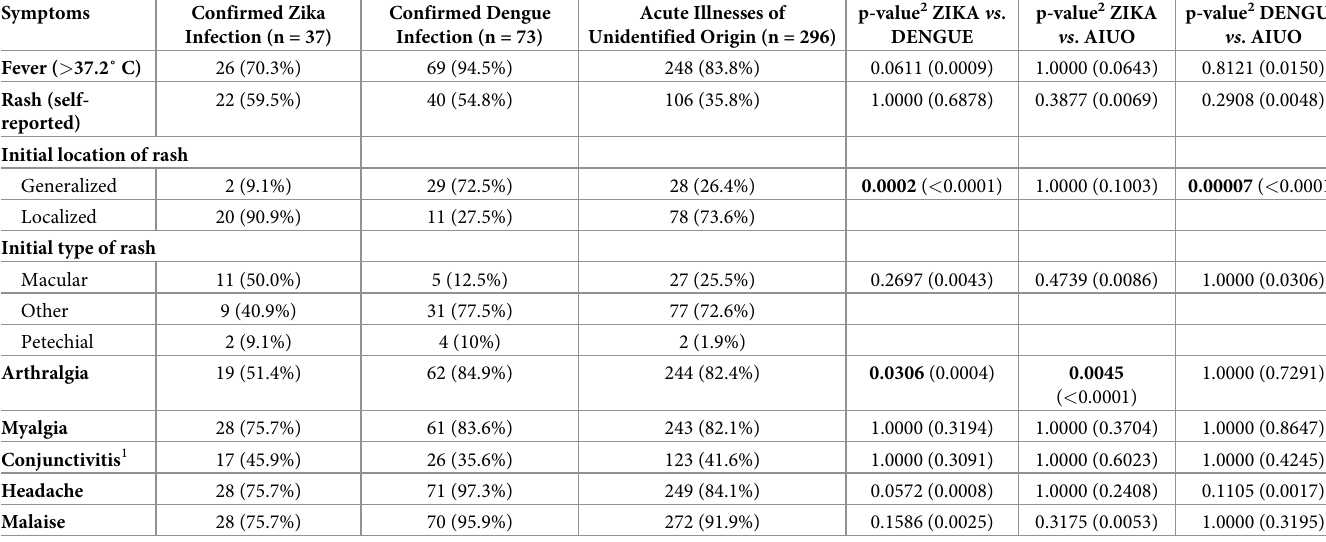
reported localized rash as opposed to patients with dengue that reported predominantly gener- alized rash (72.5%). Patients with AIUO with rash, reported it as generalized in 26.4% of cases. These differences were statistically significant (Table 2). Additionally, the frequency of type of rash differs by group: 50% of patients with Zika reported macular rash in comparison with 12.5% with dengue and 25.5% with AIUO. Table 2. Distribution and characteristics of baseline, self-reported signs and symptoms of patients 12 years and older seeking care within 7 days of onset due to acute episodes of fever and/or rash (N = 406).